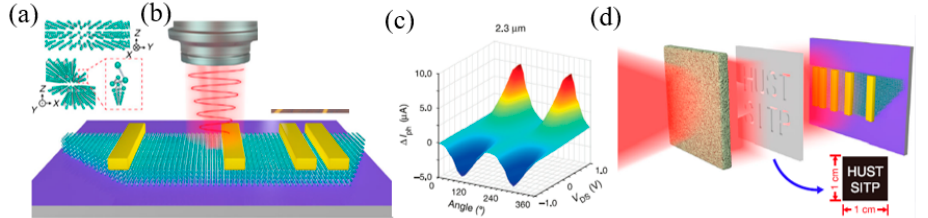
Figure 30. ( a ) The crystal structure imaging of Te, and wherein three atoms form a chain. ( b ) Schematic diagram of Te PD. ( c ) The net polarized photo-generated current Δ Ip when the band of incident light is 2.3 μ m in ambient temperature, and the incident power is 6.0 mW. ( d ) Infrared imaging method structure diagram [160]. Copyright 2020 Nature Publishing Group.